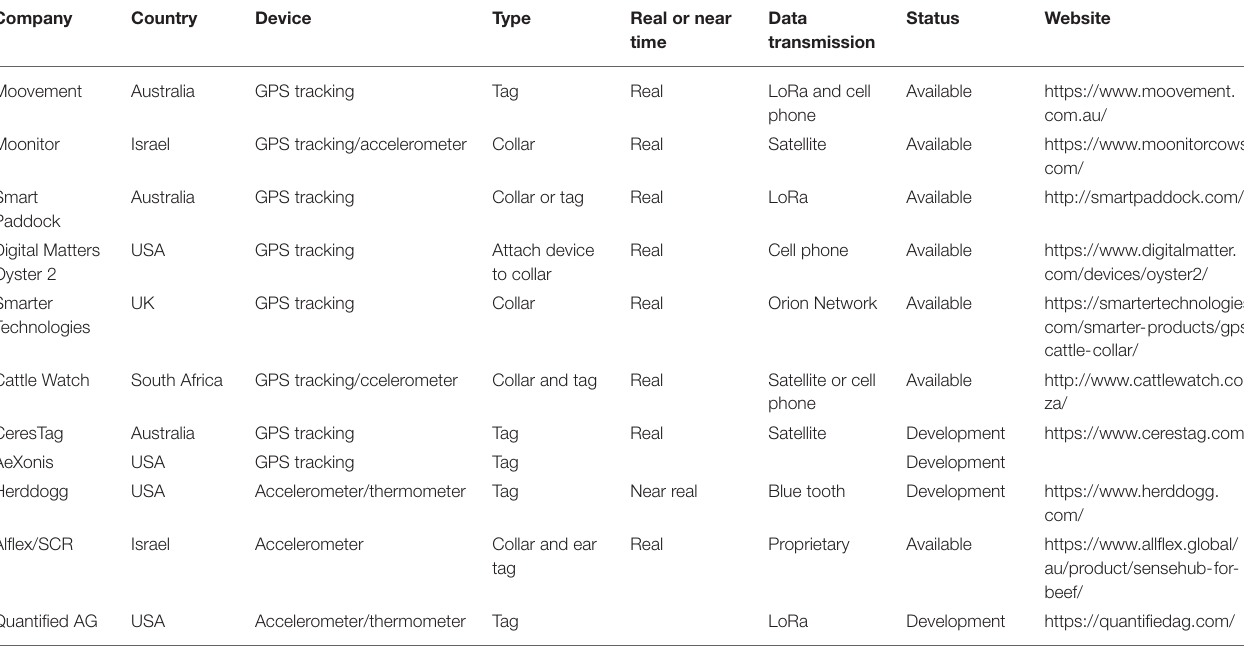
TABLE 1 | Non-exhaustive listing of companies that have developed or are developing on-animal, real-time or near-real time tracking and sensors for livestock grazing rangelands.